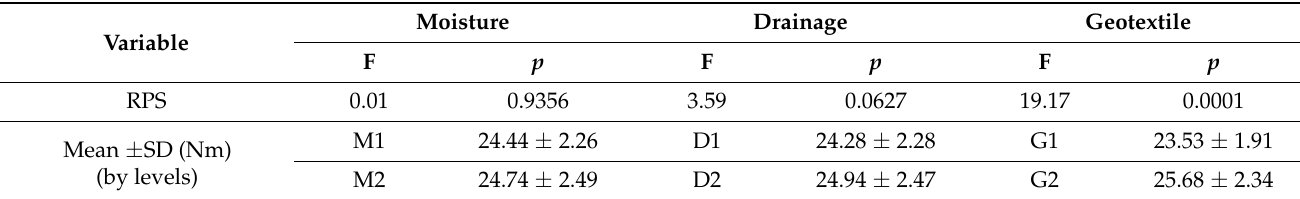
Table 6. Statistic of RPS (f and p -value), mean and standard deviation of RPS to three factors moisture, drainage and geotextile